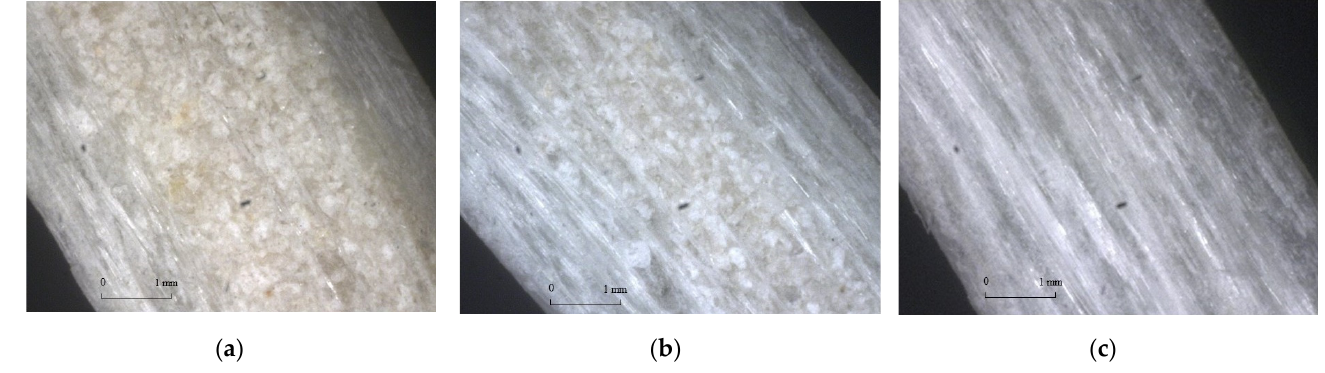
Figure 2. Schematic diagram of GFRP pipe wall structure. ( a ) Type I GFRP pipes ( b ) Type II GFRP pipes ( c ) Type III GFRP pipes